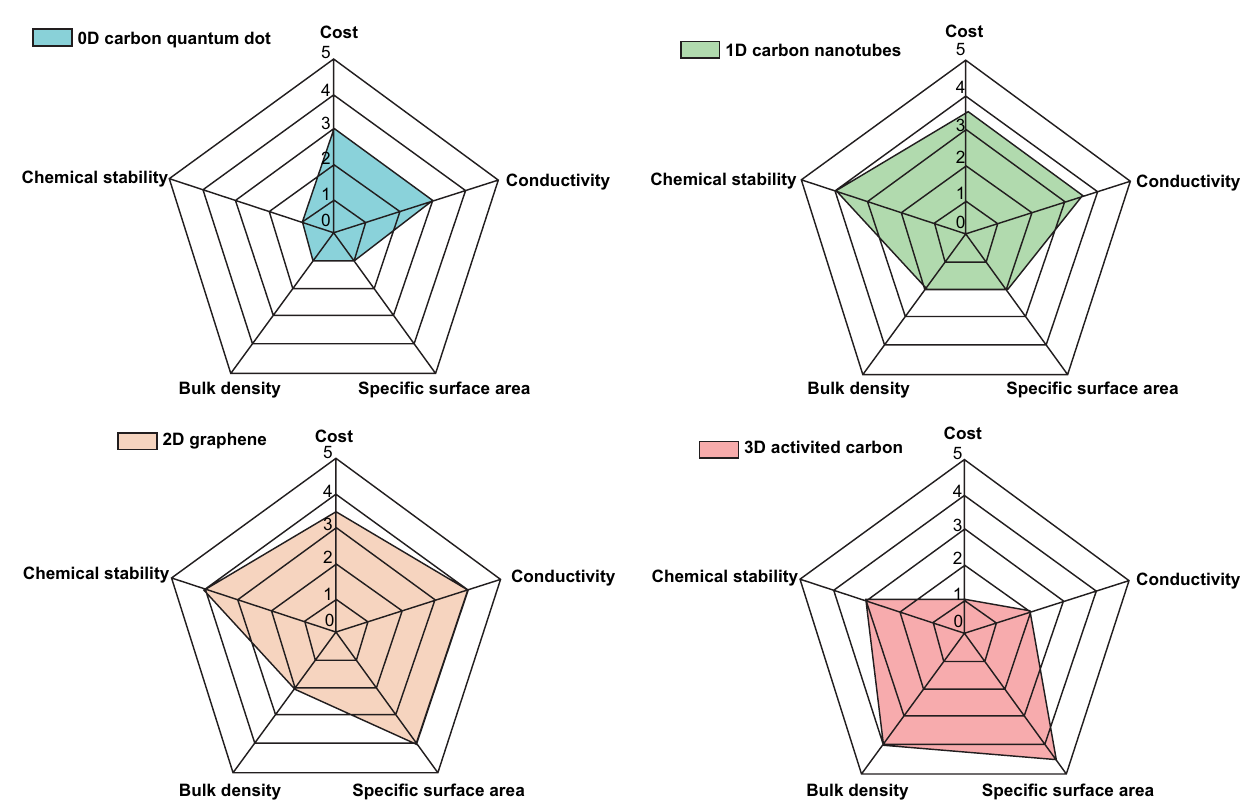
Fig. 2 Comparison of the physicochemical properties of different dimensions